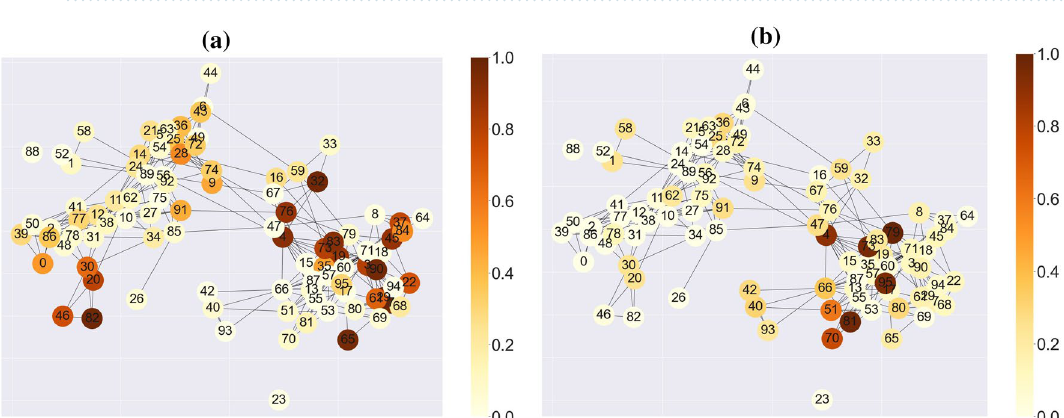
Figure 8. Co-occurrence interaction graphs of CholeraInf dataset with nodes coloured based on relevance scores of the LRP method, which are summed across each state: ( a ) diarrhea period and ( b ) recovery period. The locations of states are obtained by clustering points of the graph embedding of the time-evolving graph via k -means. The dark brown colour indicates nodes with the highest